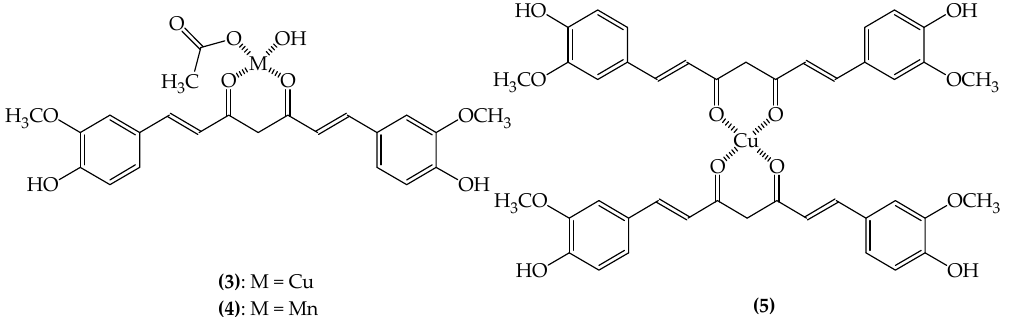
Figure 5. Chemical structures of bioactive metal–curcumin complexes ( 3 – 5 ).